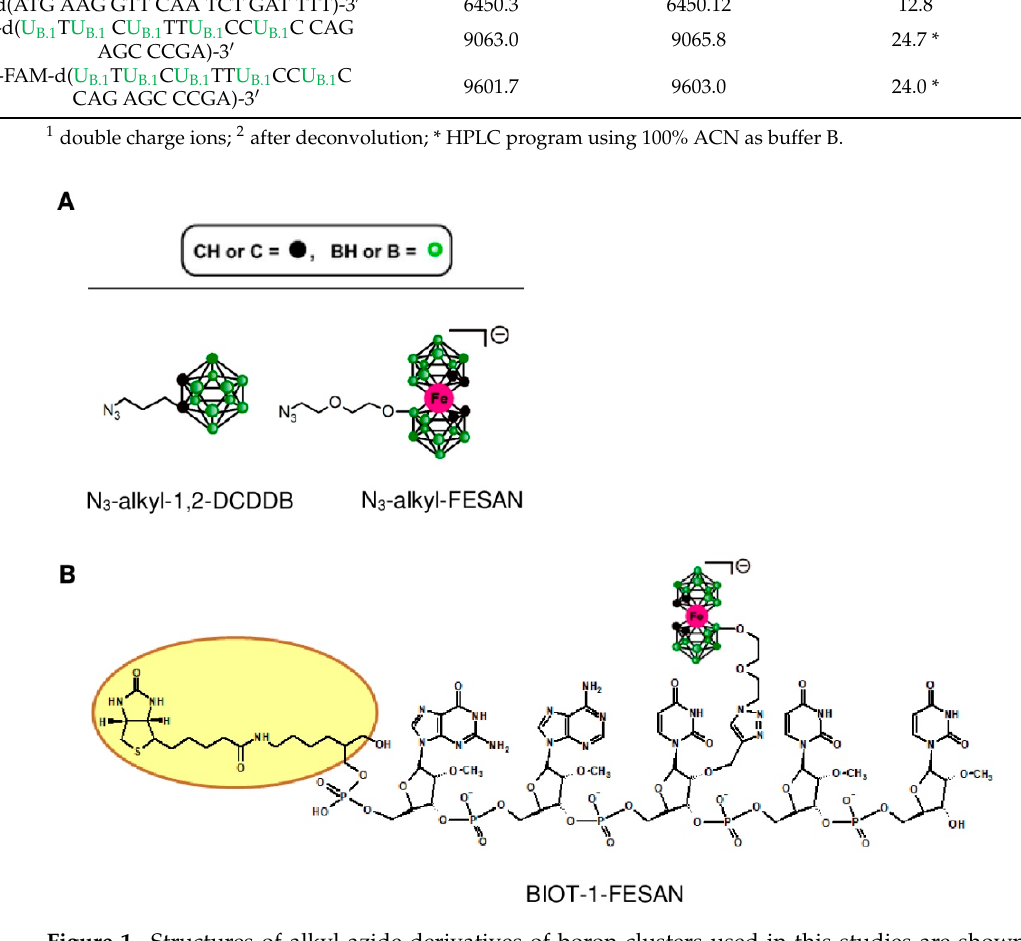
Figure 1. Structures of alkyl azide derivatives of boron clusters used in this studies are shown: N 3 -alkyl-1,2-dicarba- closo -dodecaborane (N 3 -alkyl-1,2-DCDDB, [C 2 B 10 H 12 ]) and N 3 -alkyl-[(3,3 ′ -Iron- 1,2,1 ′ ,2 ′ -dicarbollide) − ]-(N 3 -alkyl-FESAN), [Fe(C 2 B 9 H 11 ) 2 ] − ) ( A ). Scheme of the BIOT-1-FESAN fishing